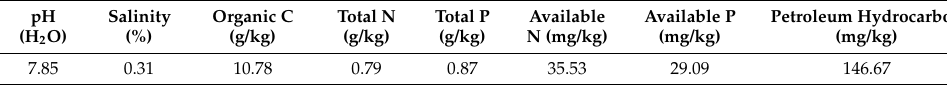
Table 2. Primary physico–chemical properties of the tested